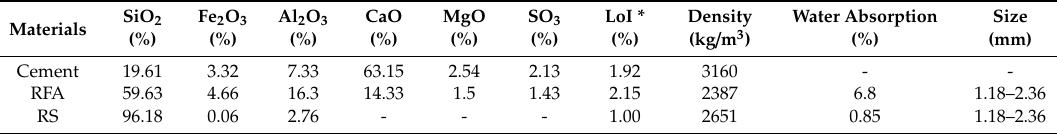
Table 1. Chemical compositions and physical properties of